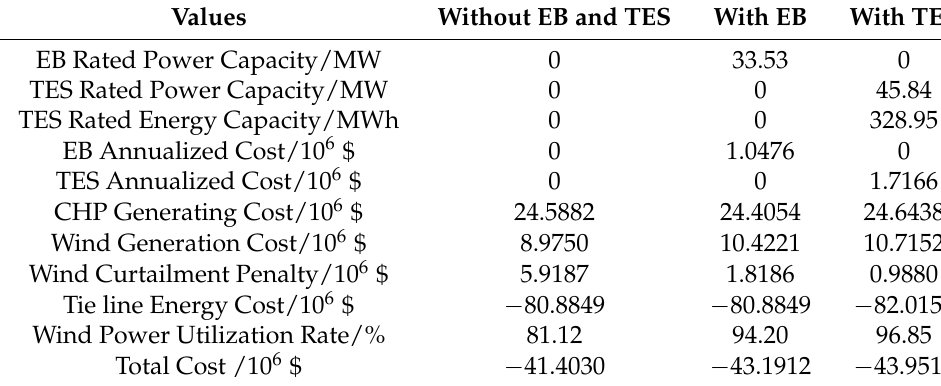
Table 3. Configuration results considering TES and